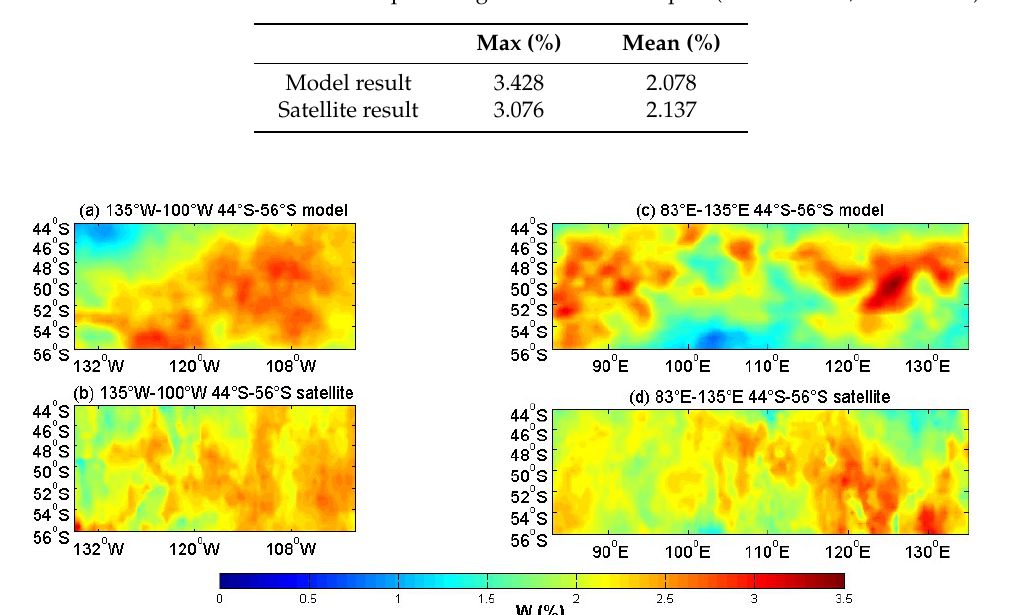
Figure 5. The whitecap coverage over the first part (44° S–56° S, 135° W–100° W) from ( a ) the model and ( b ) the satellite, and over the second part (44 °S–56 °S, 83 °E–135 °E) from ( c ) the model and ( d ) the satellite.